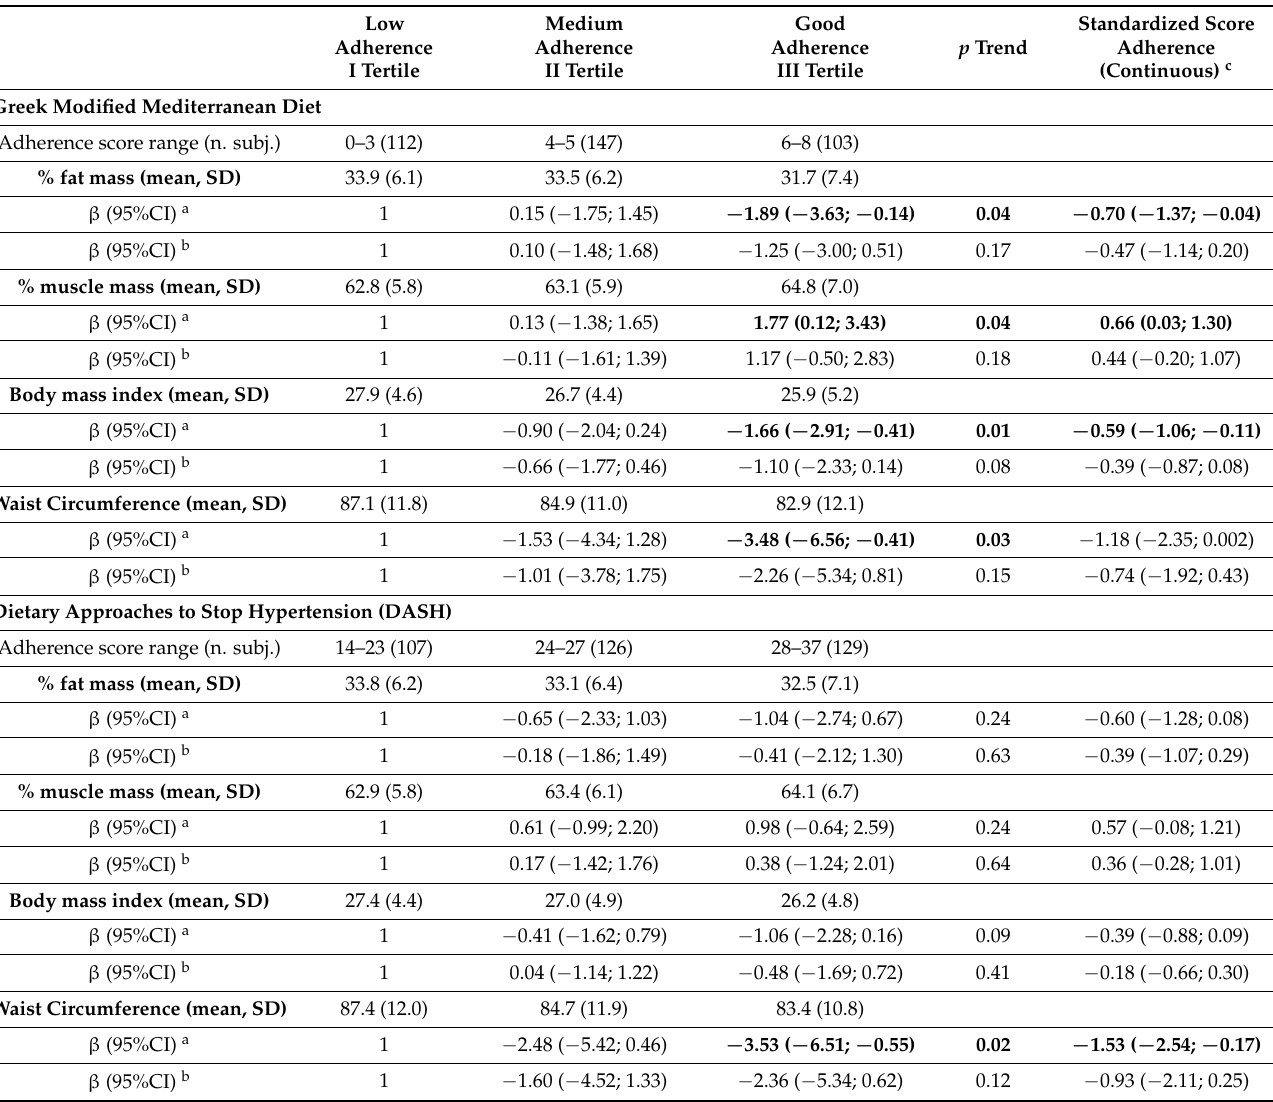
a Regression model adjusted for age (years, continuous), height (cm), smoking habits (dummy variables for current and former smokers, never-smokers as reference category), number of children (categorical), educational level (dummy variables for high school and university, none/primary school as reference category) and time from menopause (years, continuous). b Regression model further adjusted for sitting time (categorical variable for ≤ 2 h/day, >2– ≤ 4 h/day, >4 h/day), recreational activity (MET-hours/week, continuous) and household activity (MET-hours/week, continuous). c The regression coefficient ( β ) represents the adjusted difference in body composition measures between two consecutive standardized values of adherence to the three patterns. In models not adjusted for PA variables, “good adherence” as compared to “low ad- herence” was associated with a significantly lower BMI when IMD ( β − 2.19, 95%CI −